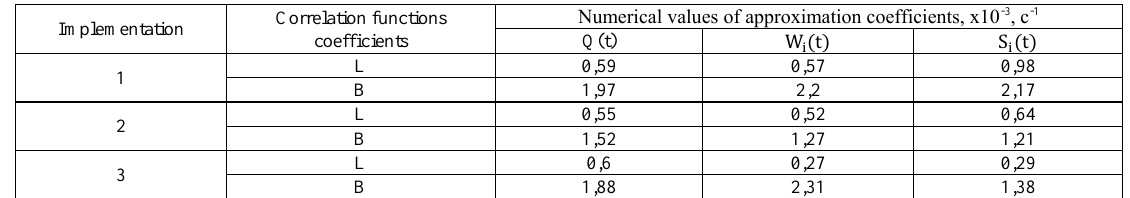
initial moisture 𝑊 (𝑡) and initial dockage 𝑆 (𝑡) . 𝑖 𝑖